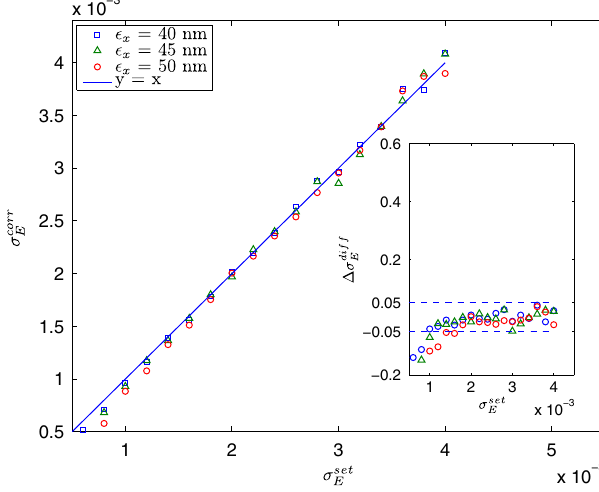
FIG. 10. (Color) Comparison of the emittance-effect corrected FIG. 8. (Color) Constrained parameter space of ( (cid:1) set E ; (cid:3) ), the x energy spread (cid:1) corr E and set value (cid:1) set E for (cid:3) shaded area, is used to determine the emittance correction The inset shows the relative difference between (cid:1) corr E and (cid:1) set E . 2 ½ 1 ; 4 : 5 (cid:4) and 4 : 00 (cid:2) formula. The shaded area is defined by a x 10 (cid:1) 4 (cid:8) (cid:1) set 1 : 60 (cid:2) 10 (cid:1) 3 E (cid:8)